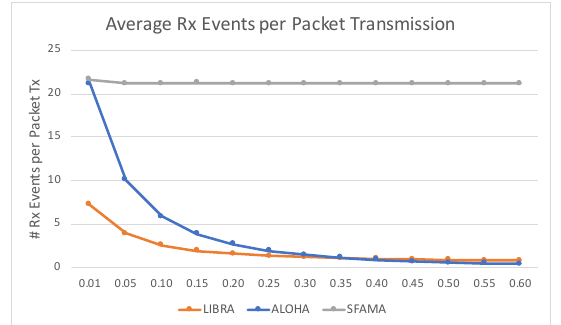
Figure 10. Average number of Rx events per packet transmission.